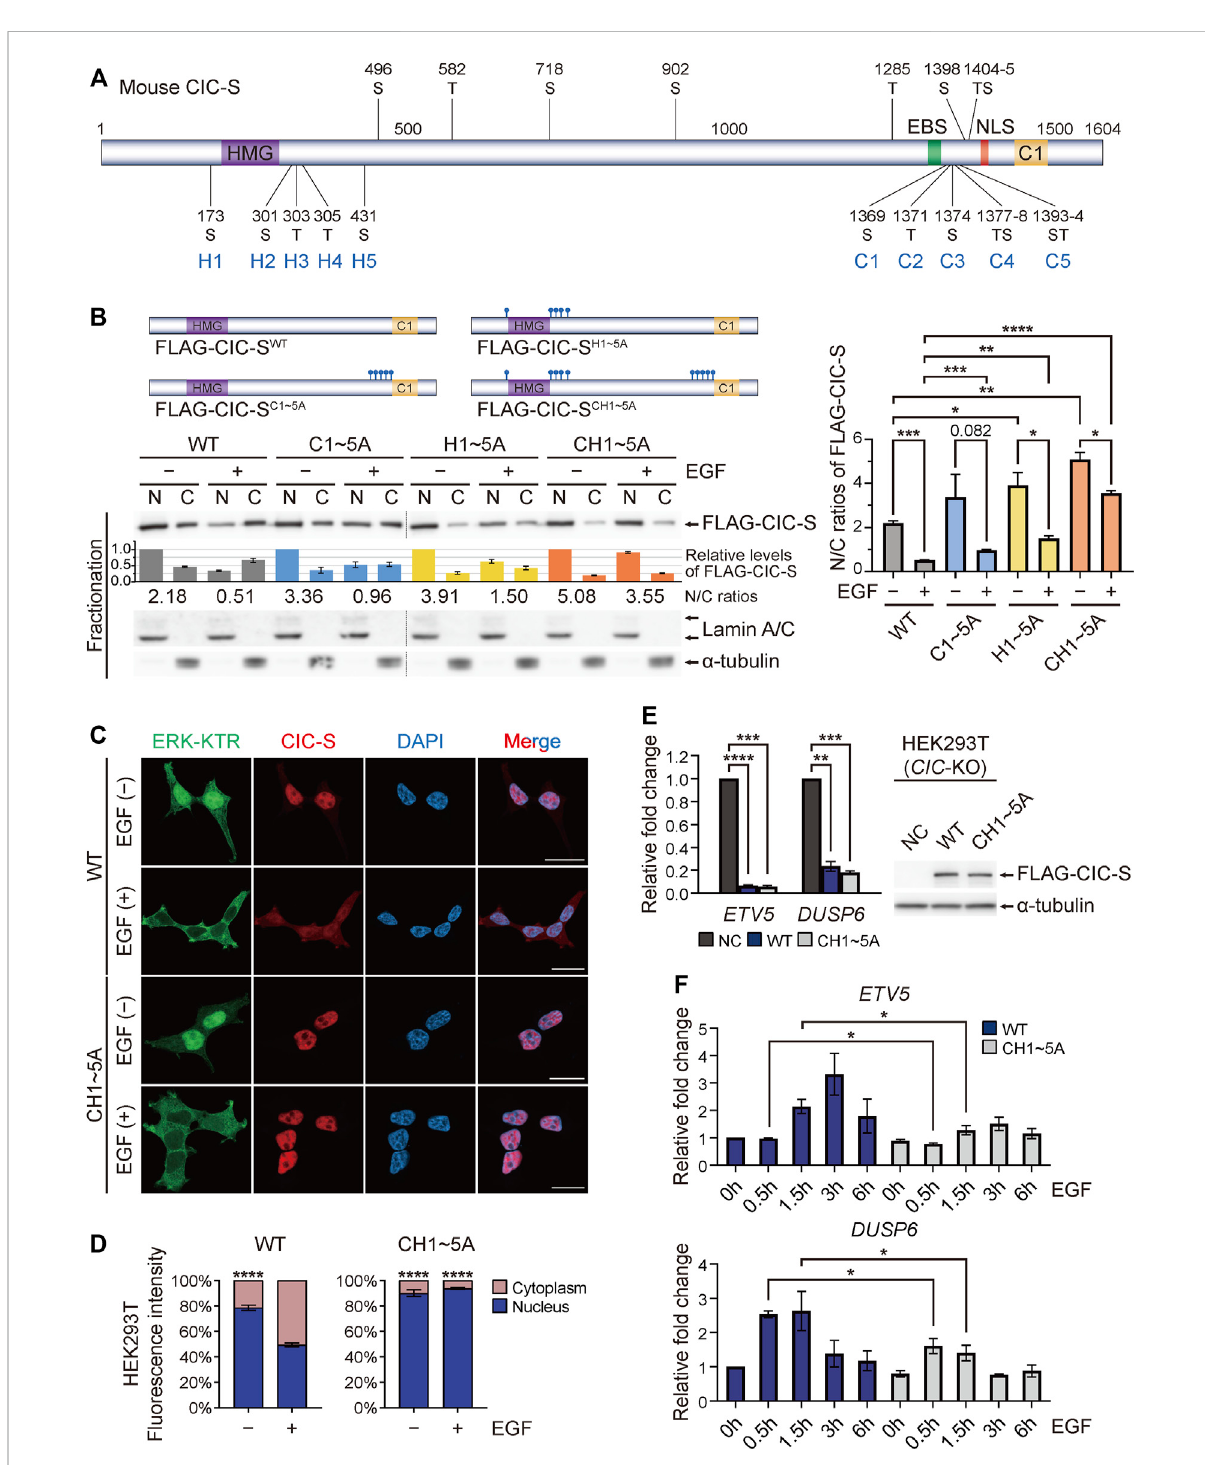
Identi fi cationofserineandthreonineresiduesinCICcontributingtoEGFtreatment-inducedcytoplasmictranslocationofCIC-S. (A) Schematic ofdomainsandpotentialEGFtreatment-inducedphosphorylationsitesinmouseCIC-S.Serine(S)andthreonine(T)residuessubstitutedwithalanine are denoted by C1 to C5 and H1 to H5. EBS: ERK-binding site. NLS: nuclear localization signal. (B) Western blotting was performed to examine changesinthesubcellulardistributionofFLAG-CIC-S WT ,FLAG-CIC-S C1~5A ,FLAG-CIC-S H1~5A ,andFLAG-CIC-S CH1~5A inHEK293TcellsuponEGF treatment for 30 min. The upper panel shows the schematics of FLAG-CIC-S WT , FLAG-CIC-S C1~5A , FLAG-CIC-S H1~5A , and FLAG-CIC-S CH1~5A . Combinationofseparate blotimages